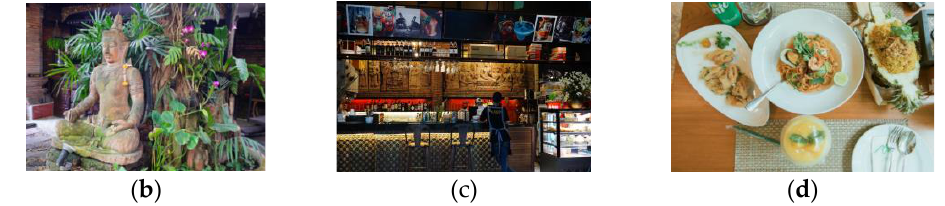
Figure 3. Images of staged local foodscape: ( a – c ) the physical environment with Northern Thai symbolical tropical environment and Buddhism culture; ( d ) the typical local Thai dishes with a combined flavor of western food.